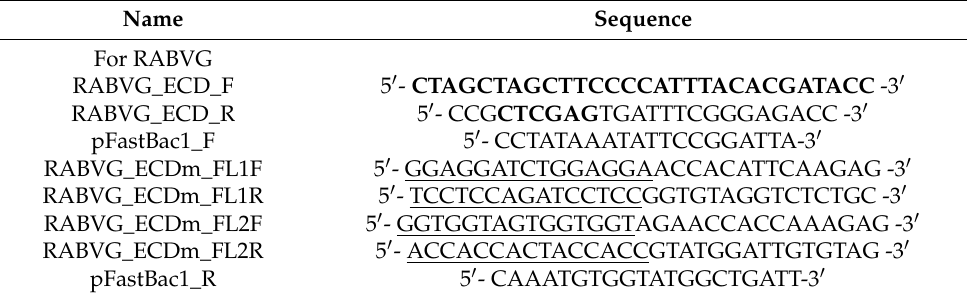
Table 2. Information on primers used for RABVG construction: Bold text indicates restriction sites, and underlines indicate mutation